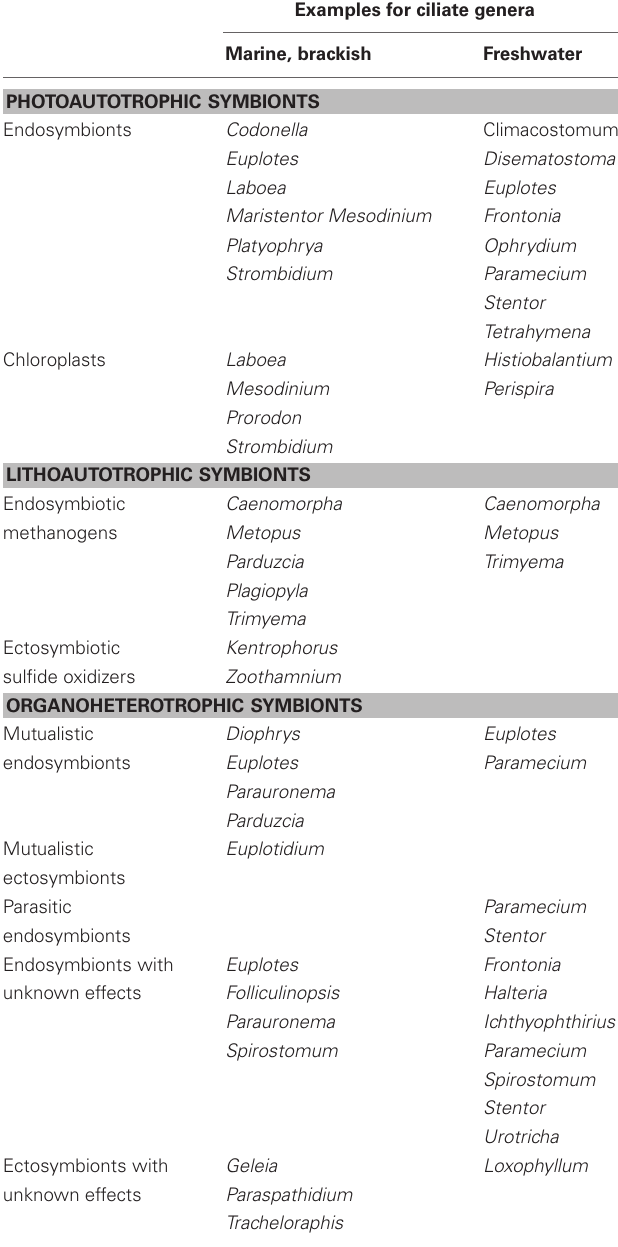
Table 3 | Overview of ciliates with